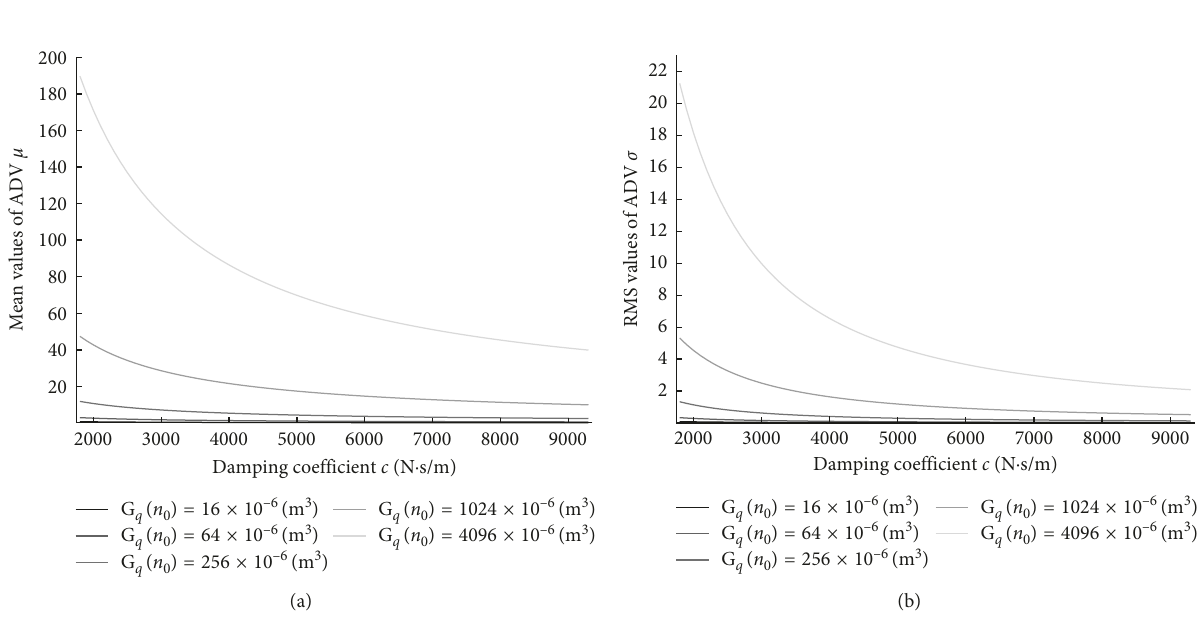
Figure 9: How sprung mass affects ADV